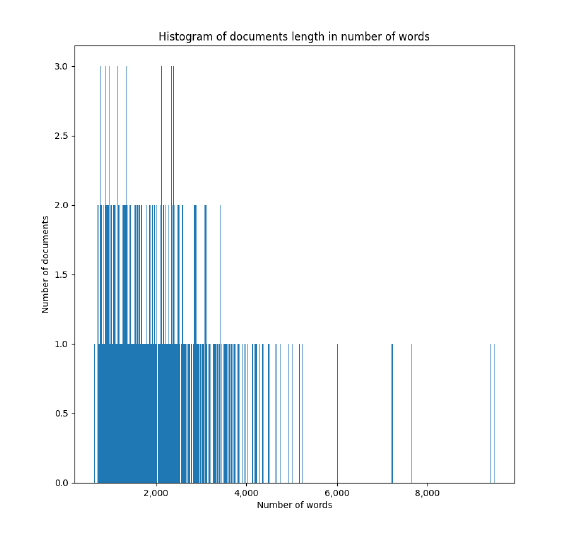
Figure 9. Distribution of words frequency in